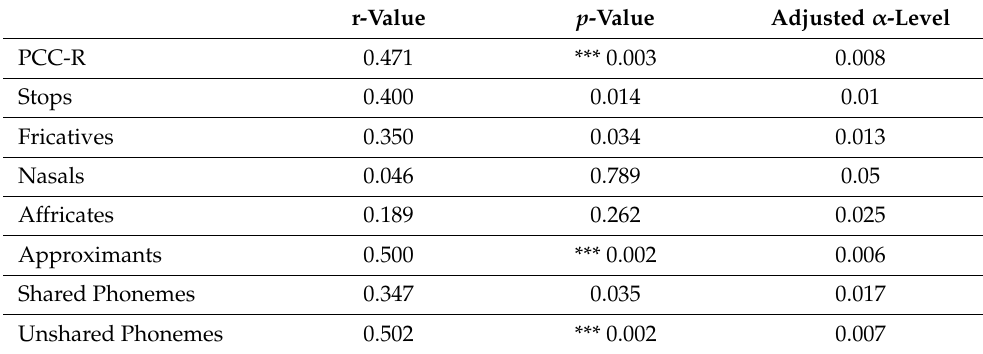
Table 4. Bivariate correlations between maternal linear acculturation scores and children’s English phonological accuracy measures; *** = significant effect (Holm–Bonferroni adjusted).